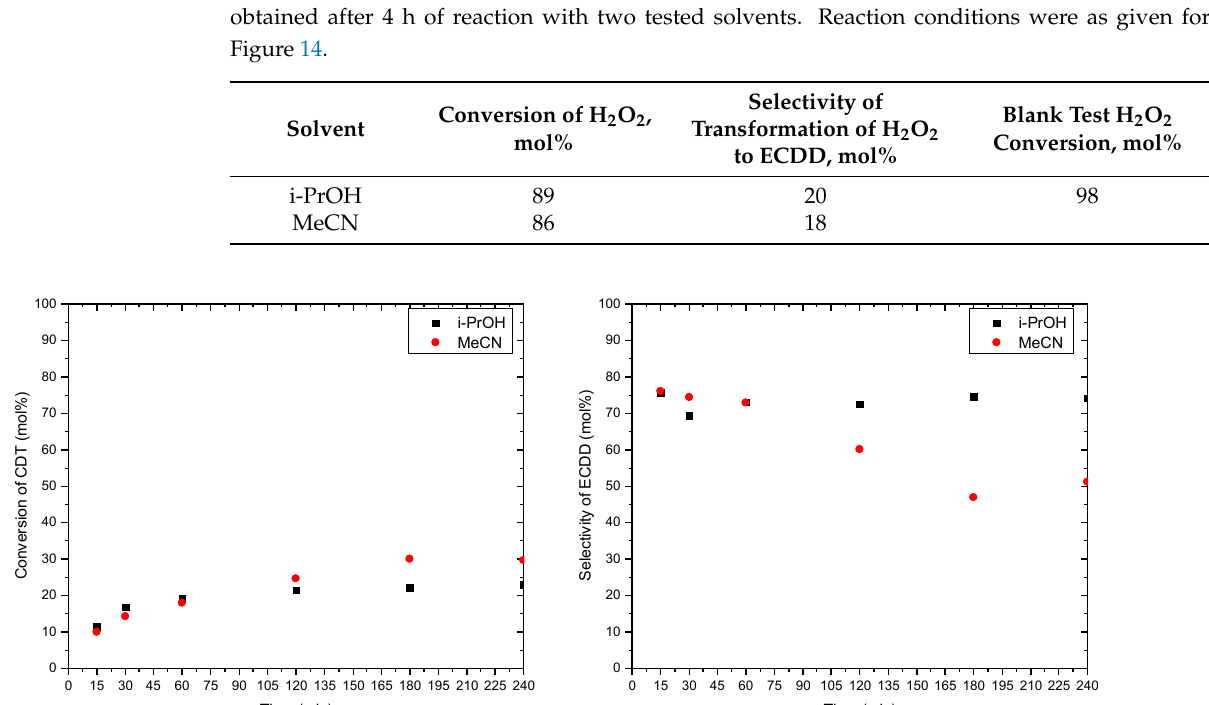
Figure 14. Conversion of CDT and selectivity of transformation of CDT to ECDD as a function of time for reactions performed with different types of solvents. Reaction conditions: solvent concentration, 80 wt%; CDT:H 2 O 2 molar ratio, 1:1; temperature, 80 °C; catalyst, 5 wt%; mixing speed, 500 rpm. Table 4. Values of the conversion of H 2 O 2 and selectivity of transformation of H 2 O 2 to ECDD ob- tained after 4 h of reaction with two tested solvents. Reaction conditions were as given for Figure